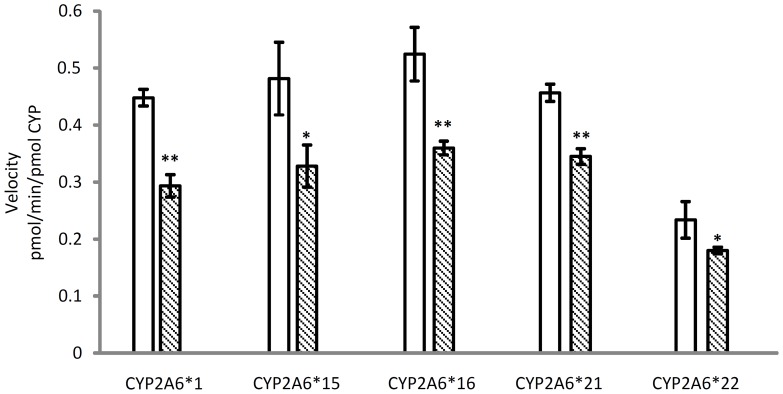
Velocity rates for coumarin 7-hydroxylation in incubations of coumarin (10 µM) without (open bars) or with (hatched bars) pre-incubation with 8-methoxypsoralen at 1.0 µM in CYP2A6 proteins.Data are shown as mean ± SD from triplicate determinations. Degree of statistical differences between incubations without and with pre-incubation as determined by two-tailed Student's t test: the mean difference is significant at 0.05 level (* p<0.05) and highly significant at 0.01 level (** p<0.01).